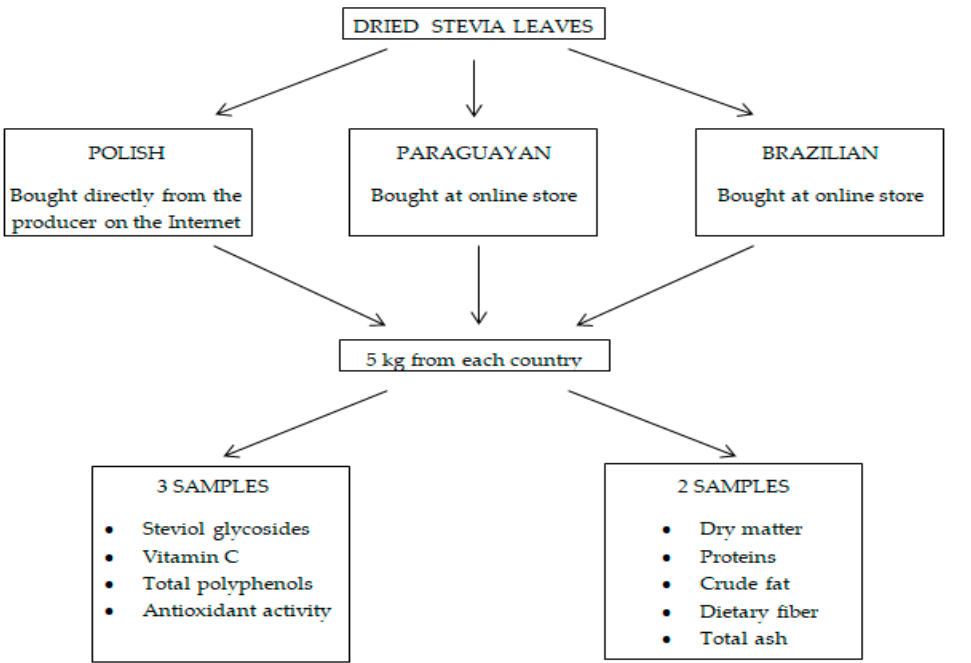
Figure 1. Scheme of obtaining research samples.